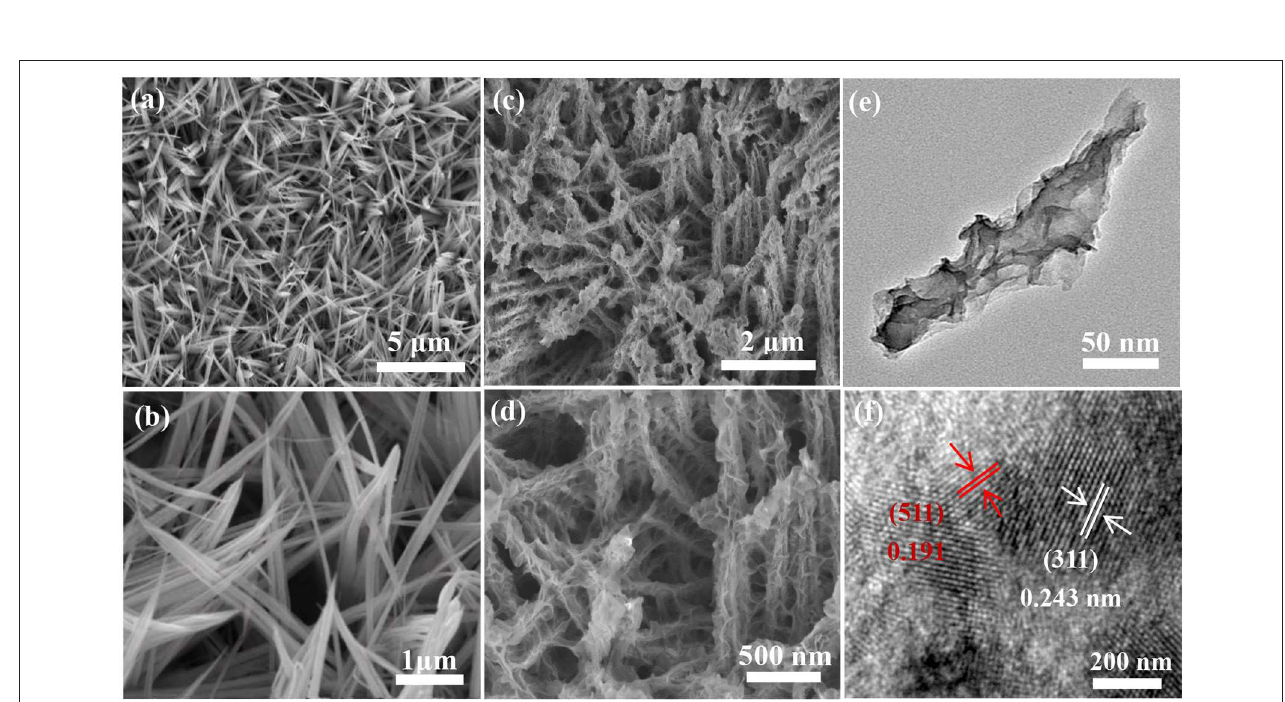
FIGURE 2 | Morphology characterization, (a,b) SEM image of Co-NWs, (c,d) Co-HSs, and (e,f) TEM images of the Co-HSs.